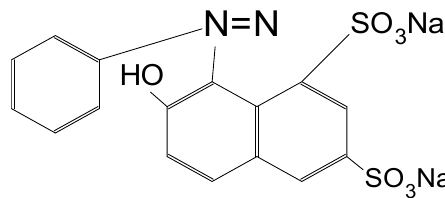
Fig. 1. The studied AO10 chemical structure